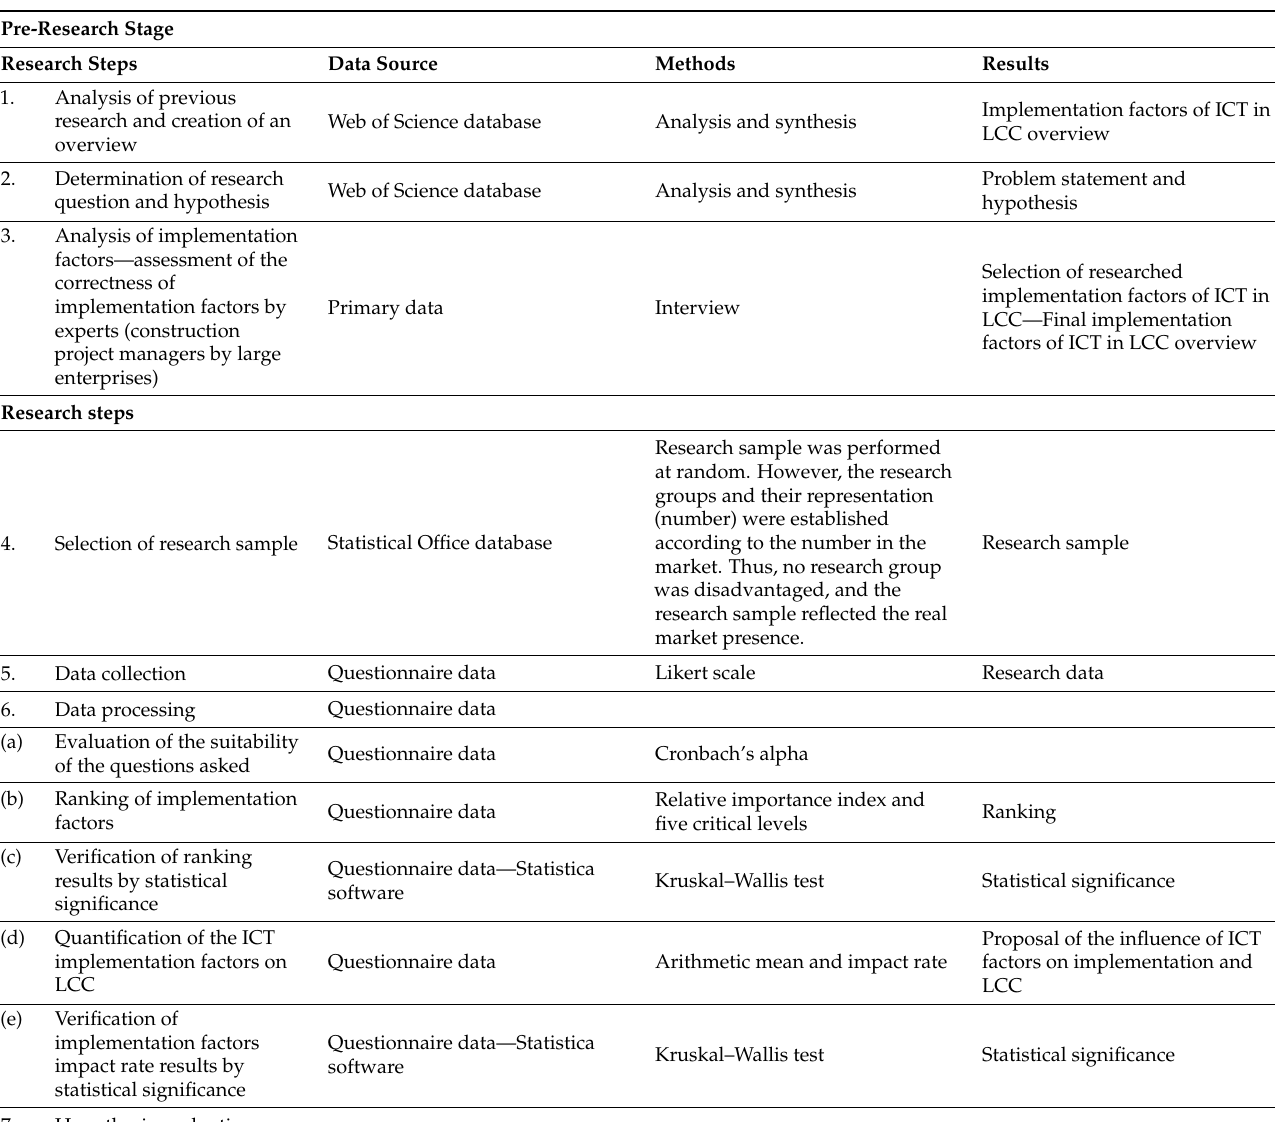
Table 3. Research methods and